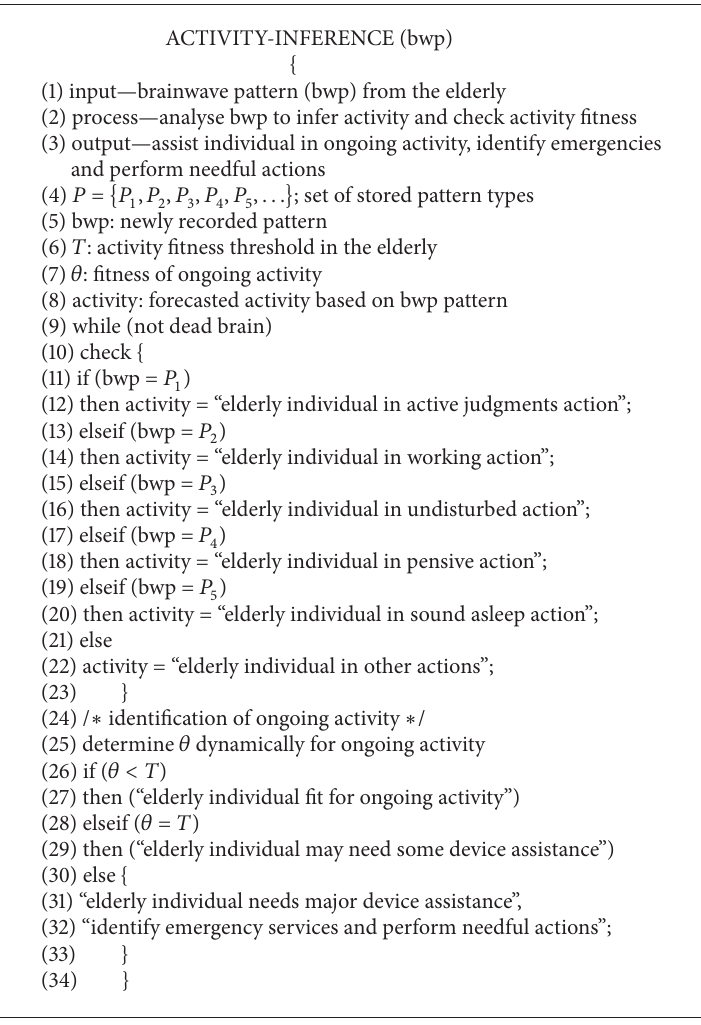
Algorithm 1: Algorithm for activity-inference from brainwave patterns in the